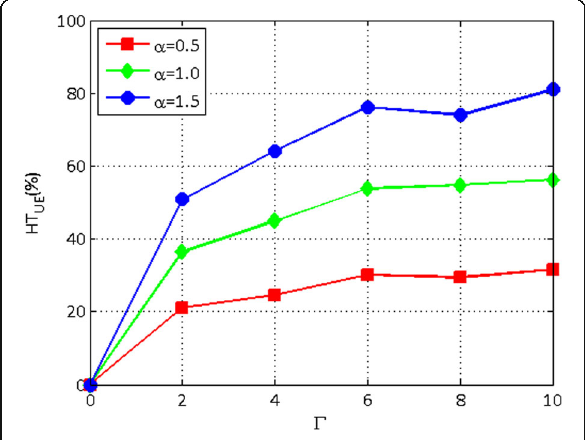
Fig. 15 Impact of Zipf parameter to hit rate in the UE level in ER model ( d UE ¼ 4 ; N UE ¼ 60 ; T SBS